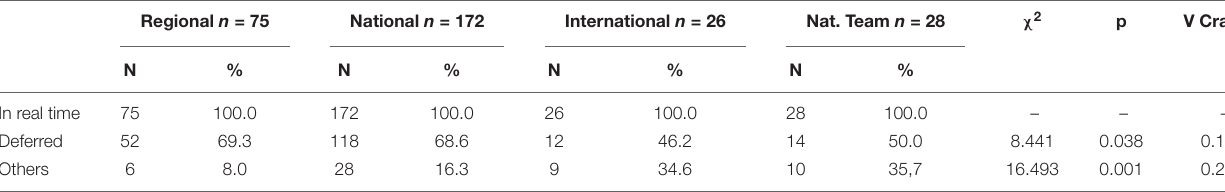
TABLE 3 | Media used during training.